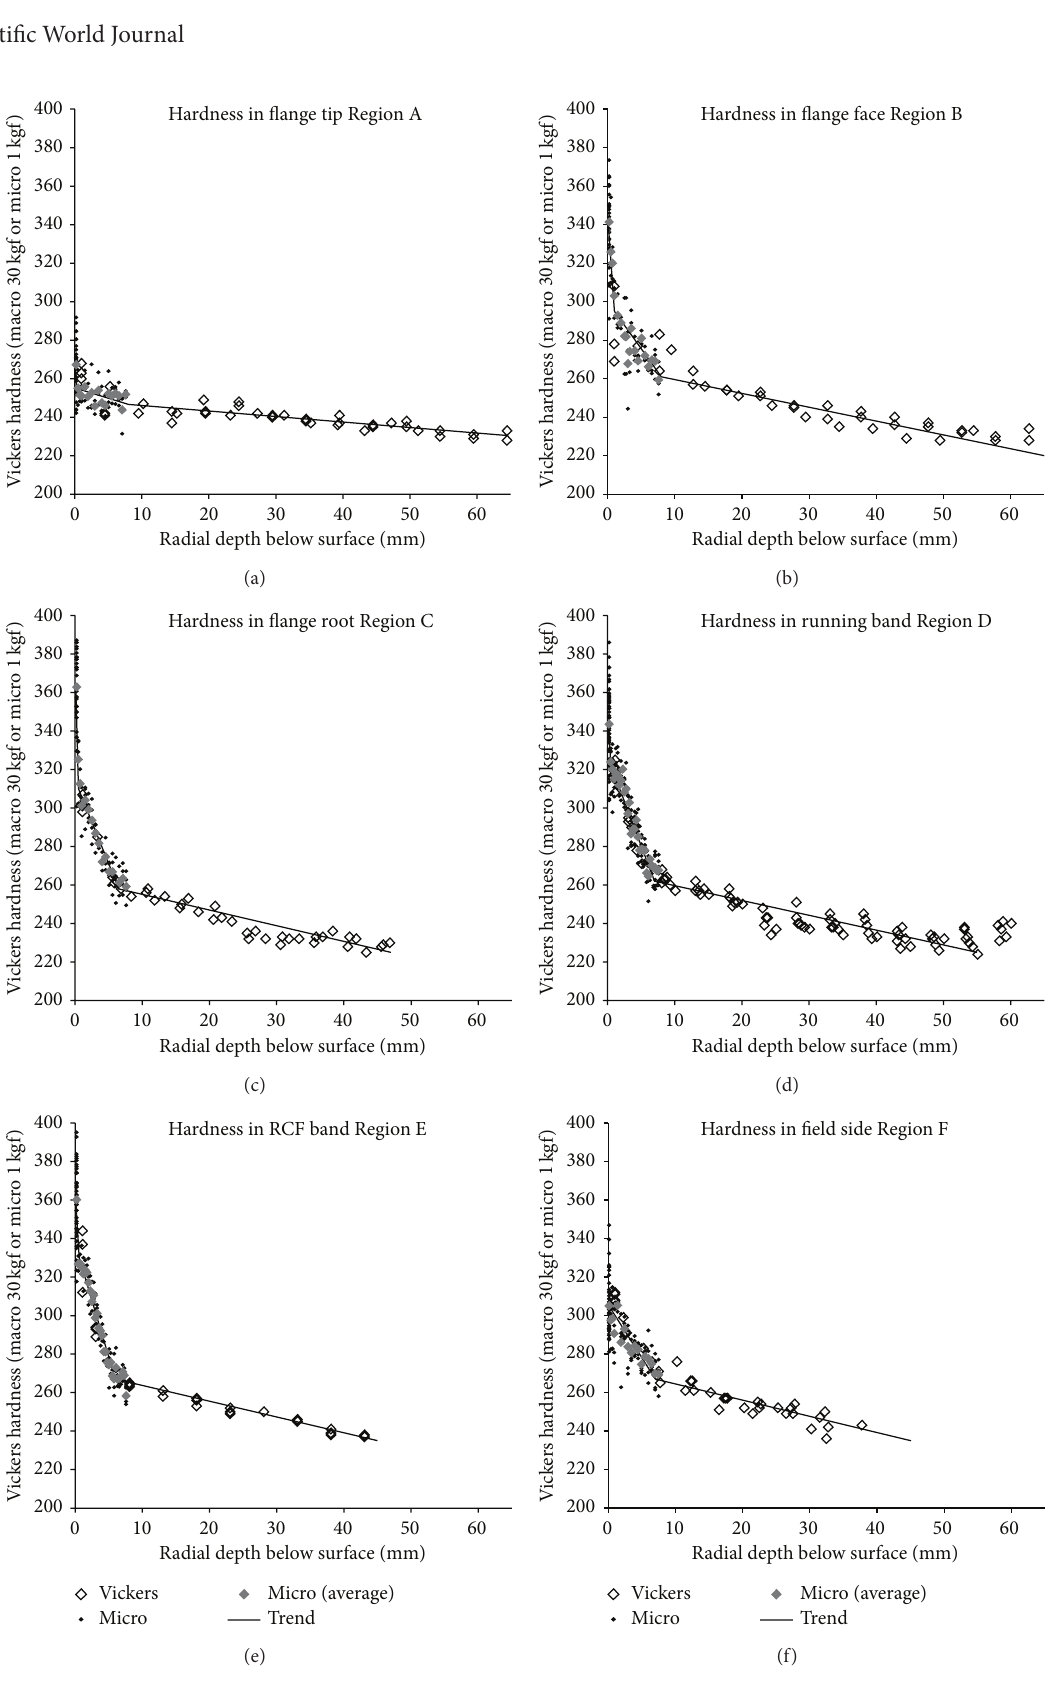
Figure 9: (a) Hardness trend, regional DMU, in flange tip (A). (b) Hardness trend, regional DMU, in flange face (B). (c) Hardness trend, regional DMU, in flange root (C). (d) Hardness trend, regional DMU, in running band (D). (e) Hardness trend, regional DMU, in RCF band (E). (f) Hardness trend, regional DMU, in field side